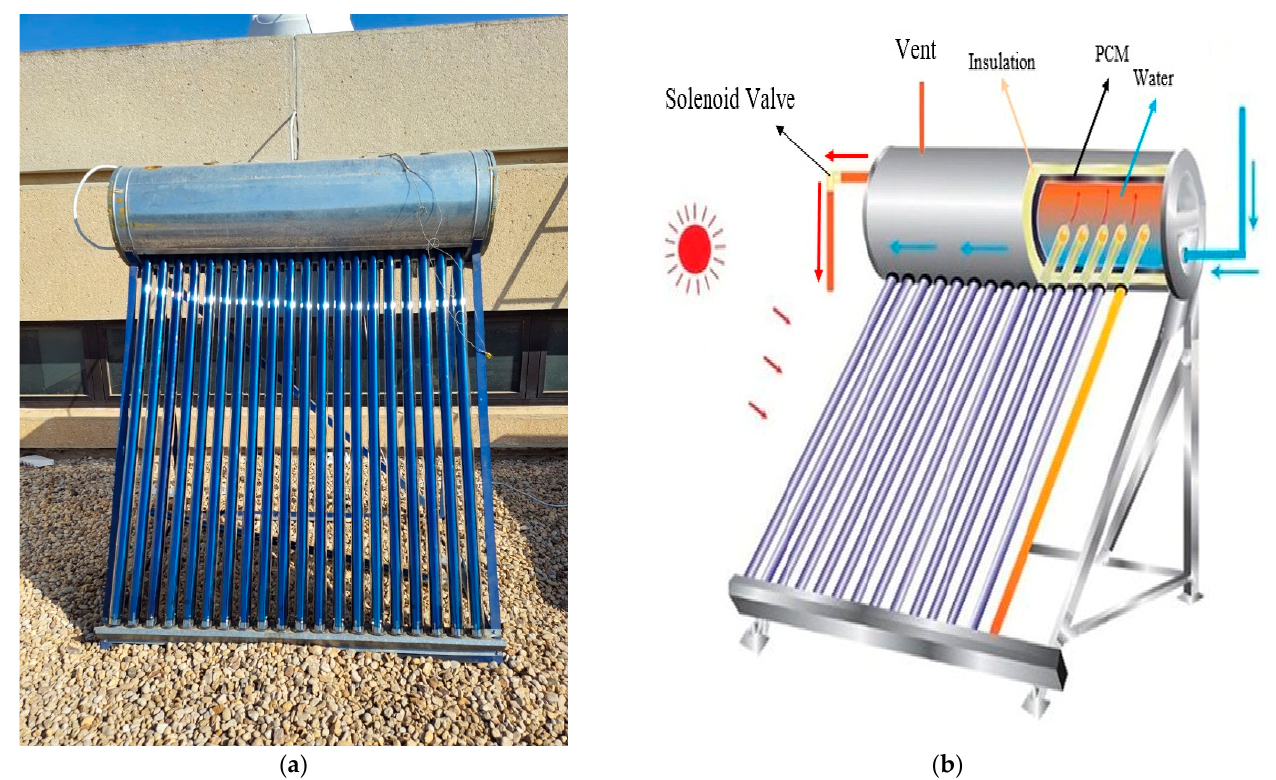
Figure 3. Hydronic evacuated tube solar system with a PCM: ( a ) photographic view; ( b ) schematic diagram.